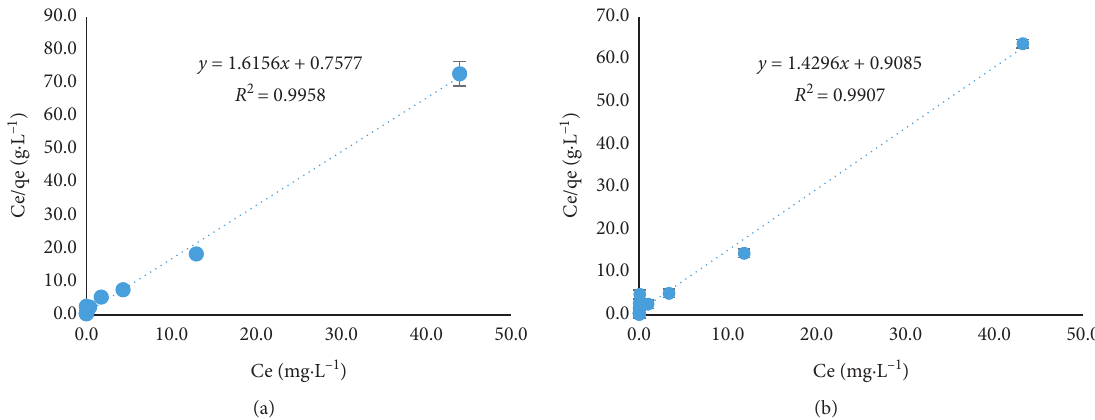
Figure 7: Effect of the initial dye concentration (0.050, 1.000, and 10.000mg · L − 1 ) on the maximum adsorption capacity ( q time (10–120min).